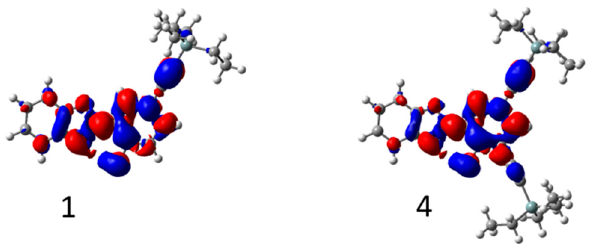
Figure 7. Density difference plot corresponding to electronic excitation of HBO 1 and 4 . The blue and red regions respectively correspond to decrease and increase of electronic density upon absorption. See S6, Scheme S6.2 in the Supplementary Material for the other dyes.